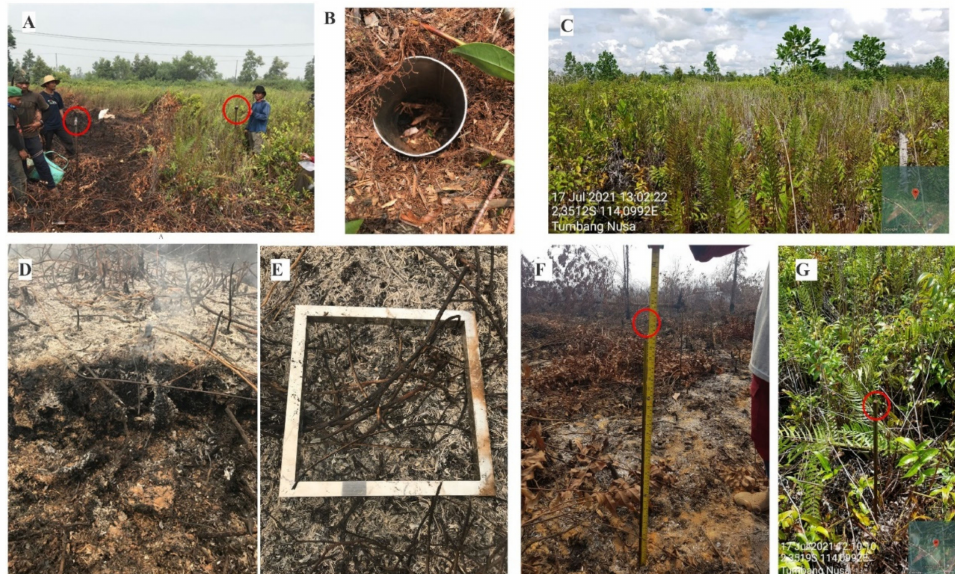
Figure 2. Photos of study sites: ( A ) Site 1 during July 2019 measurements, showing burned and unburned locations, red circles indicate position of peat auger samples taken from burned and unburned sites; ( B ) sampling of roots, rhizomes and peat using a metal ring; ( C ) Site 1 in July 2021 showing recovery of vegetation; ( D ) Site 2 in September 2019 showing exposed roots, one day after peat fire burned the area; ( E ) sampling of shrubs and litter at burned sites, where the red circle indicates the metal rod; ( F ) Site 2, measurements of surface combustion using a metal rod indicated by the red circle; and ( G ) Site 2 in July 2021 showing recovery of vegetation and